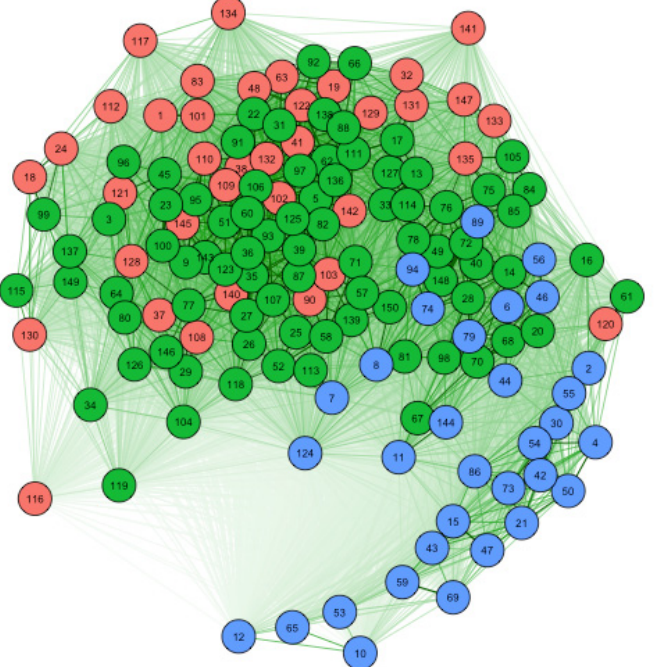
Figure 5. Network graph of the benchmark clusters.